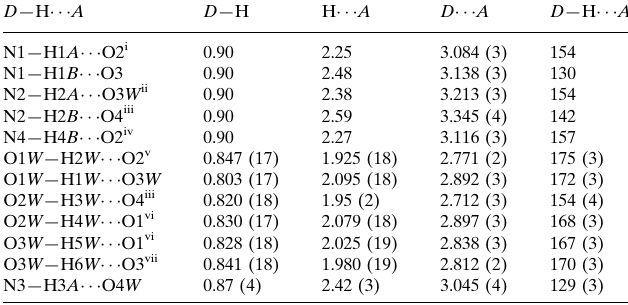
Hydrogen-bond geometry (A˚ , (cid:3)